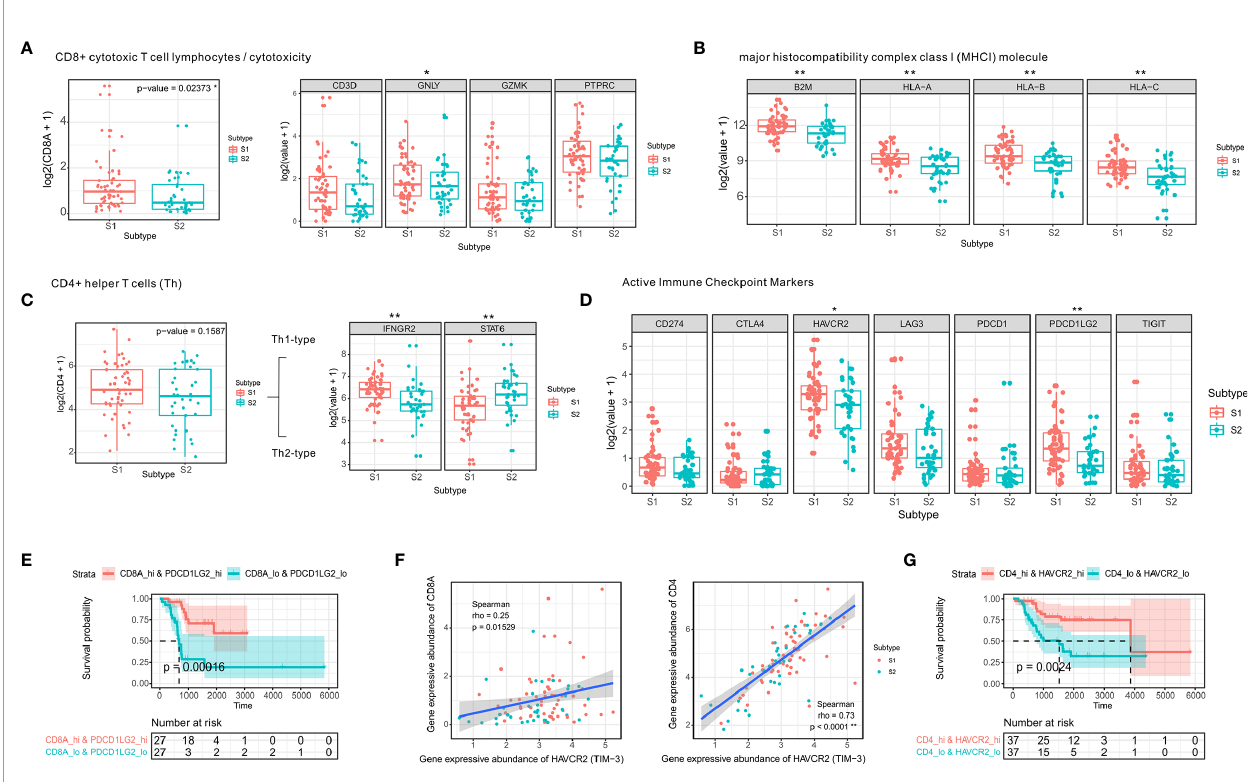
FIGURE 3 | CD4 ⁺ Th1 and CD8 ⁺ cytotoxic T-cell in fi ltration and increased expression of immune checkpoint molecules. (A) Comparison of expression levels of CD8 ⁺ T-cell markers. (B) Comparison of expression levels of MHC class I molecules. (C) Boxplot of the expression of CD4 ⁺ T-cell markers in two the OSA TME subtypes S1 and S2. (D) Comparison of levels of immune checkpoints in the different subtypes (E) Prognostic value of CD8A+PDCD1LG2 co-expression groups based on Kaplan-Meier survival analysis. (F) Spearman correlation between HAVCR2 and CD4/CD8A expression. (G) Prognostic value of CD4+HAVCR2 co- expression groups based on Kaplan-Meier survival analysis. The signi fi cance levels of the p-values are presented as *p < 0.05 or **p <